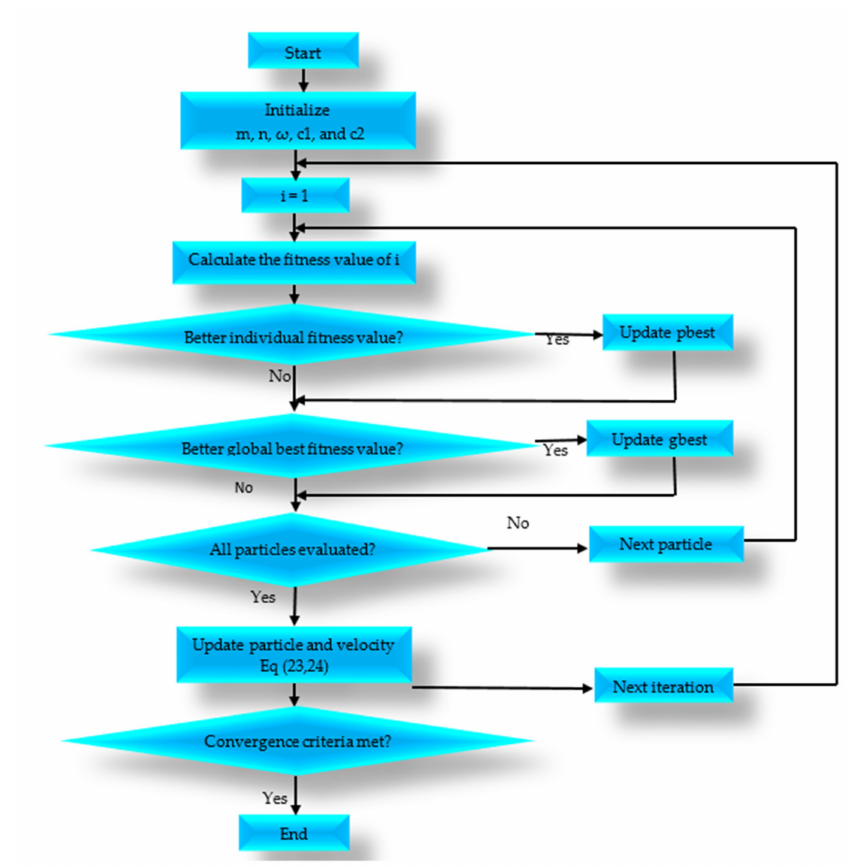
Figure 3. PSO flow